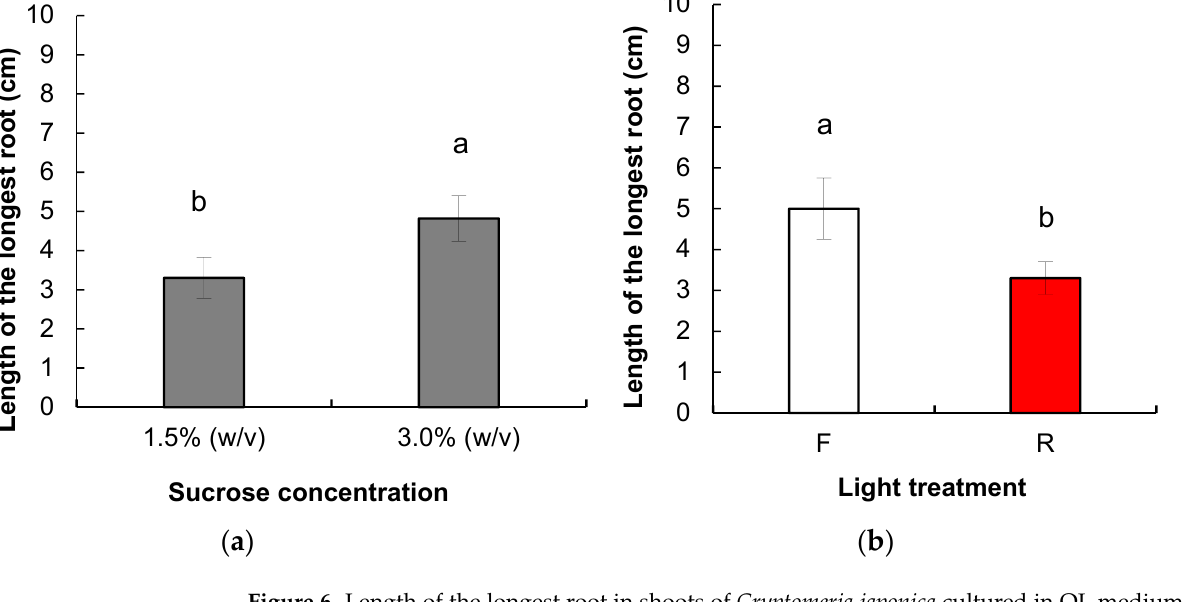
Figure 6. Length of the longest root in shoots of Cryptomeria japonica cultured in QL medium [15], according to sucrose concentration (3% and 1.5% ( w/v ) ( a ) and light treatments (fluorescent light (F) and red LEDs (R)) ( b ). Data are presented as mean values ± S.E. Significant differences are indicated by different letters according to Tukey’s post hoc test ( p < 0.05).